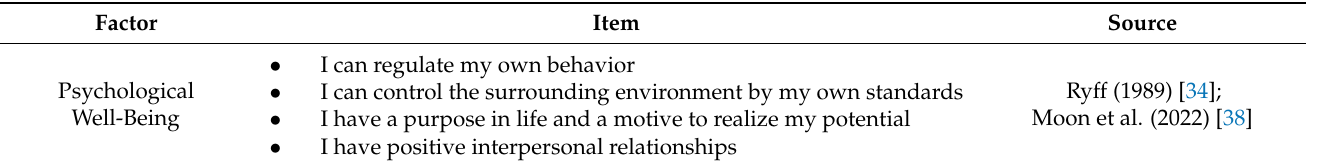
Table 1. Psychological well-being of active senior campers.